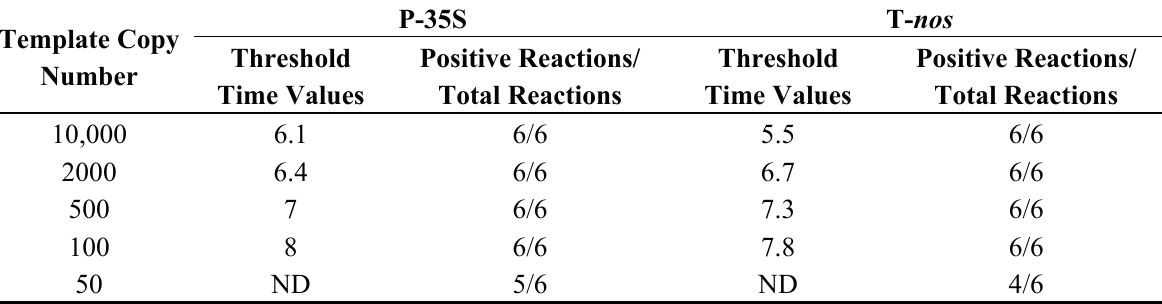
Table 3. Sensitivity test for P-35S and T- nos real-time RPA